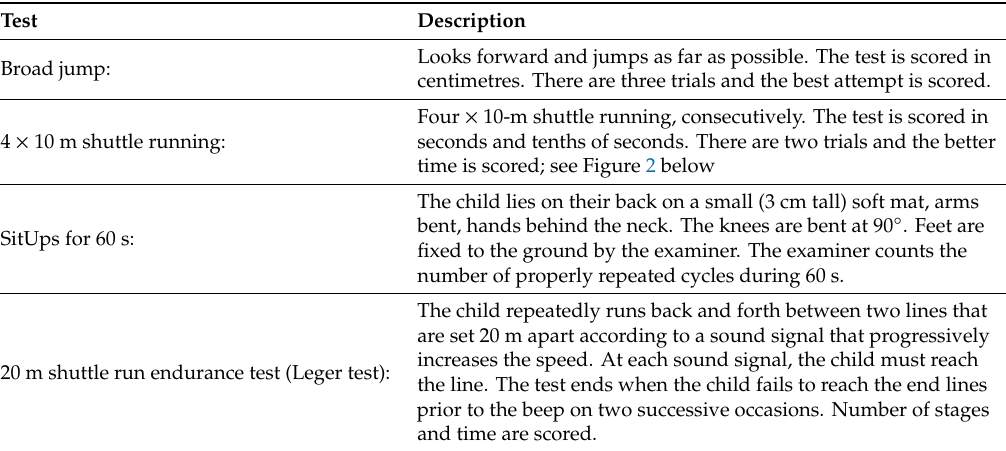
Table 1. Description of physical fitness